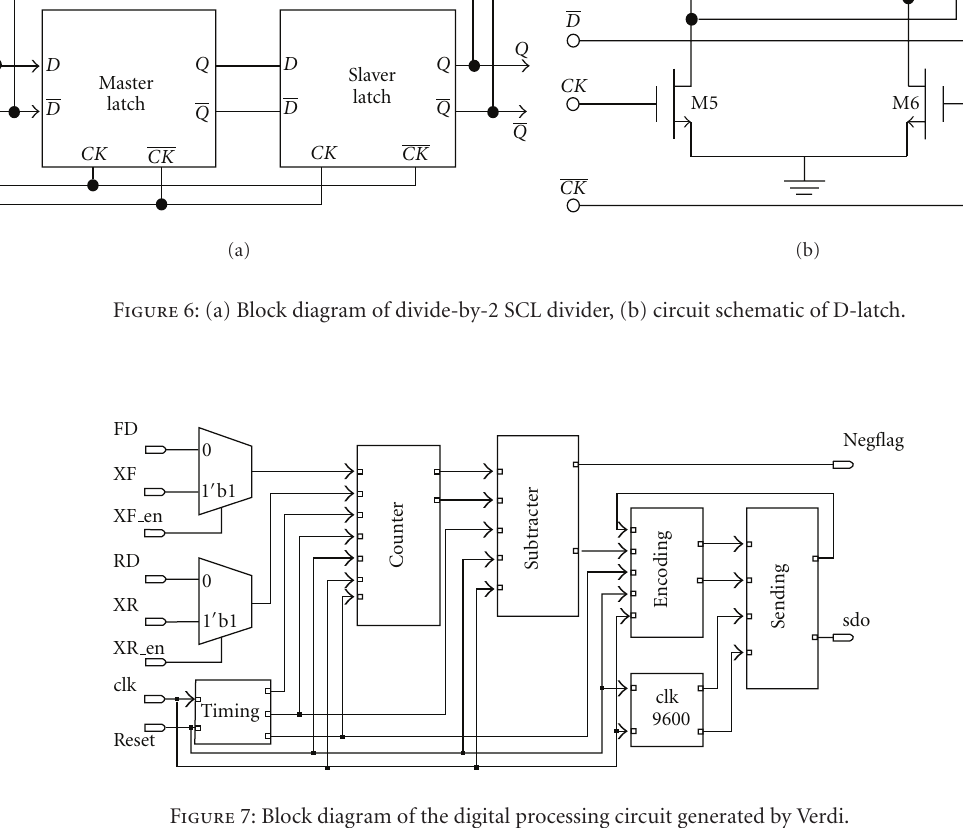
Figure 7: Block diagram of the digital processing circuit generated by Verdi.